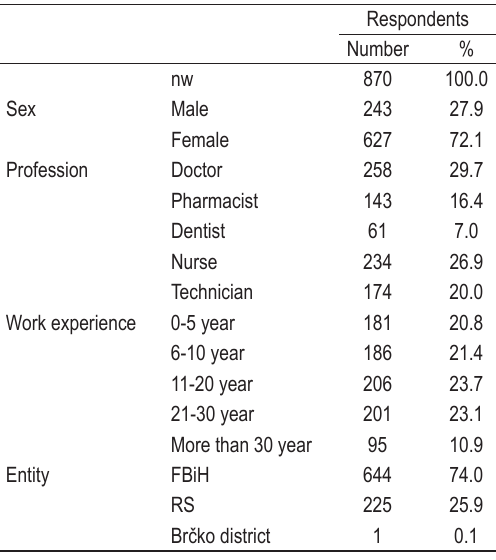
Table 1. Demographic and professional details of